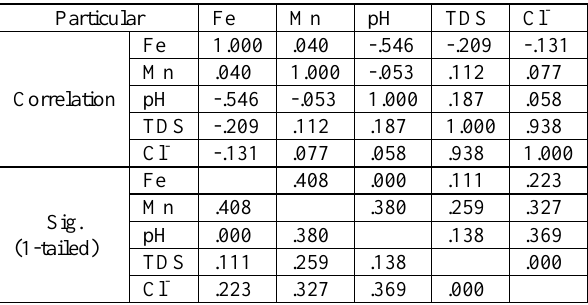
Table 8. Correlation matrix